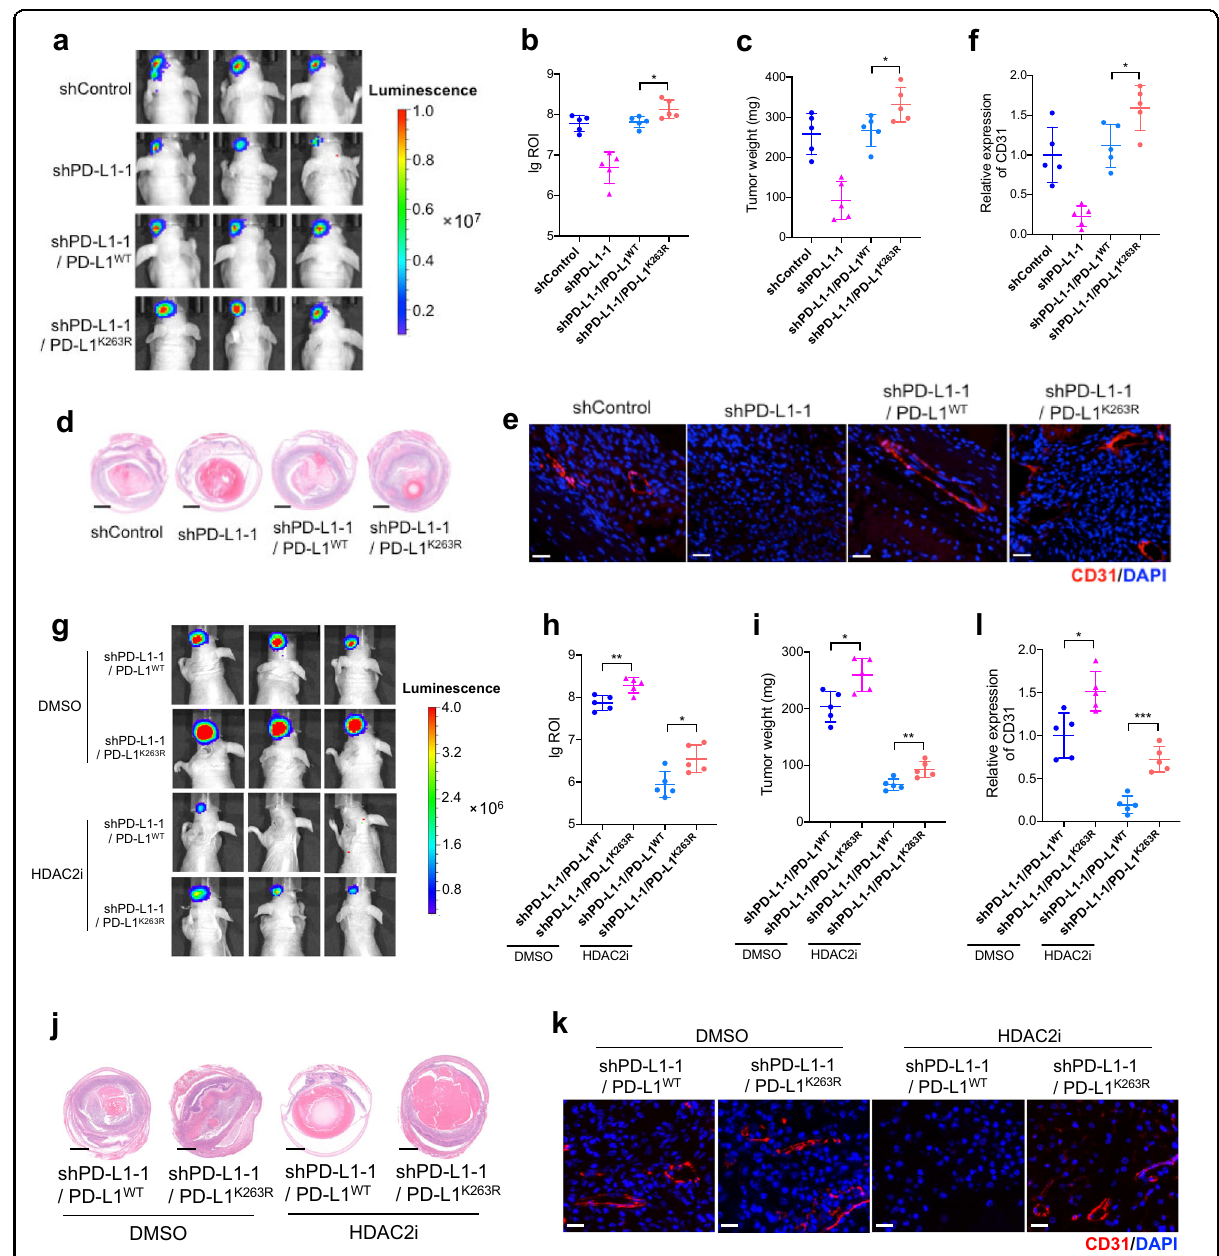
Fig. 7 PD-L1 K263 deacetylation facilitates angiogenesis and tumorigenesis in vivo. a Representative bioluminescent images of UM orthotopic xenografts. b Statistical analysis of the bioluminescent signals in UM orthotopic xenografts. n = 5. c Statistical analysis of the tumor weight. n = 5. Data are presented as means ± SD. Two-tailed unpaired Student ’ s t -test. d Representative images of H&E staining of UM orthotopic xenografts generated by tumor cells with indicated constructs. e IF images of CD31 in UM orthotopic xenografts generated by tumor cells with indicated constructs. Scale bars, 40 µm. f Statistical analysis of CD31 expression in UM orthotopic xenografts. n = 5. Data are presented as means ± SD. Two- tailed unpaired Student ’ s t -test. g Representative bioluminescent images of UM orthotopic xenografts generated by tumor cells with indicated constructs and treated with HDAC2i. h Statistical analysis of the bioluminescent signals in UM orthotopic xenografts. n = 5. i Statistical analysis of the tumor weight. n = 5. Data are presented as means ± SD. Two-tailed unpaired Student ’ s t -test. j Representative images of H&E staining of UM orthotopic xenografts generated by tumor cells with indicated constructs and treated with HDAC2i. k IF images of CD31 in UM orthotopic xenografts generated by tumor cells with indicated constructs and treated with HDAC2i. Scale bars, 40 µm. l Statistical analysis of CD31 expression in UM orthotopic xenografts. n = 5. Data are presented as means ± SD. Two-tailed unpaired Student ’ s t-